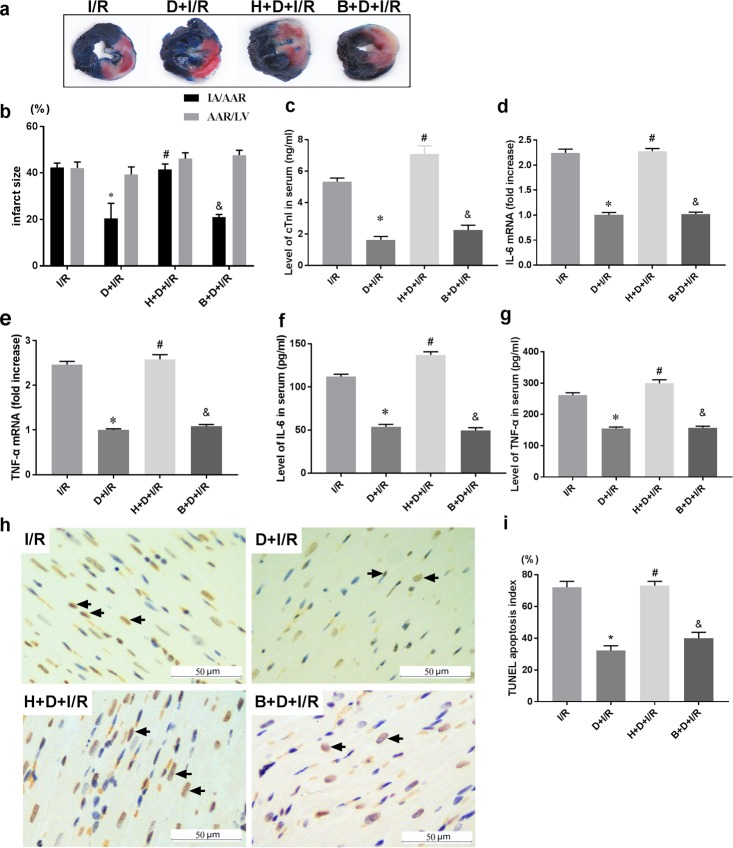
Cardiac-selective HMGB1 overexpression eliminates DEX-induced short-term cardioprotection against I/R.Rats were subjected to intrapericardial injection of AAV9-HMGB1 or AAV9-Blank as control 3 weeks before DEX pretreatment followed with the I/R operation. (a-b) Infarct size and representative images of each group are shown. (c) Serum cTnI levels; mRNA levels (d-e) and serum levels (f-g) of inflammatory cytokines including IL-6 and TNF-α were also detected. Myocardial apoptosis in infarct zone was evaluated by TUNEL staining (h-i) (arrows indicate positive cells, Scale bar = 50μm.); All specimen were obtained at the timepoint of myocardial I/R for 2hrs. Data shown are mean ± SEM; n = 10 per group; *p < 0.01 vs. I/R; #p < 0.05 vs. D+I/R; &p<0.05 vs. H+D+I/R; H: AAV9-HMGB1; B: AAV9-Blank; D: dexmedetomidine; I/R: myocardial ischemia-reperfusion;